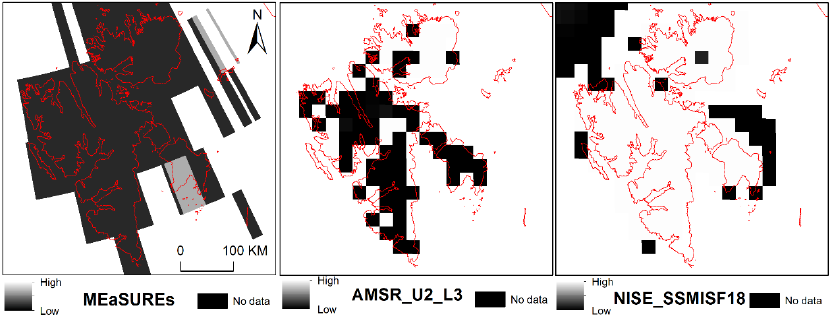
Figure 15. Passive microwave radiometer remote sensing images (MEaSUREs, AMSR_U2_L3, NISE_SSMISF18).